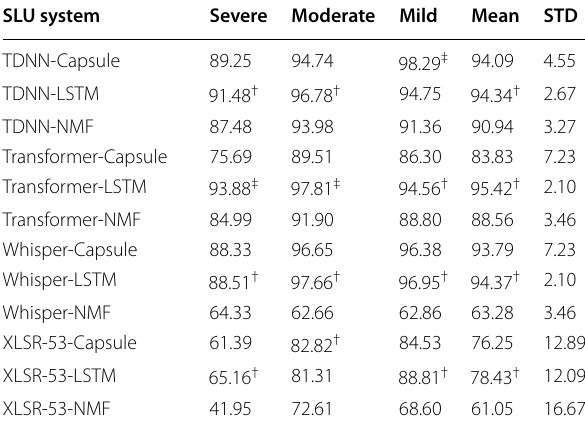
Table 5 Average SLU F1 scores per severity group. Best accuracy per severity group shown by ‡ and best SLU decoder per pre- trained encoder shown by